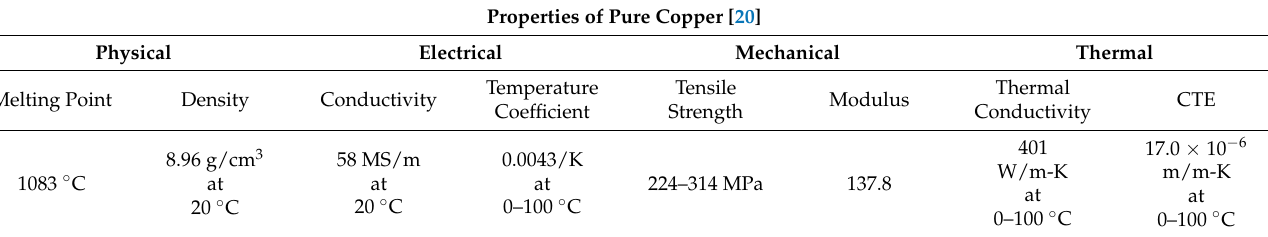
Table 1. Properties of pure